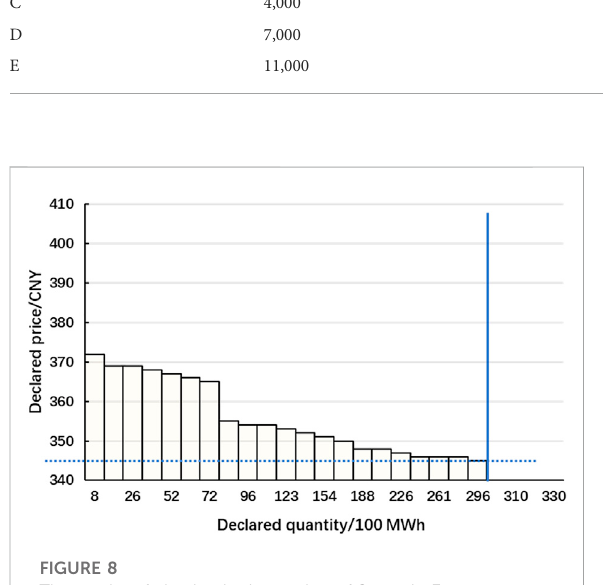
FIGURE 8 The results of clearing in the market of Scenario